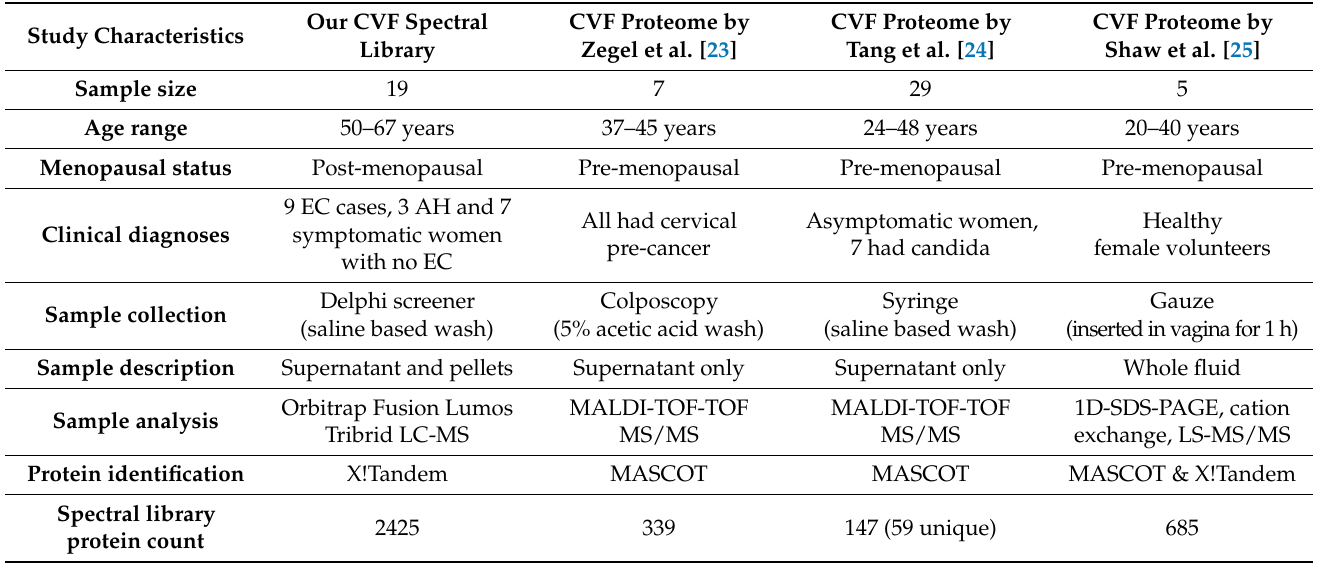
Table 4. Comparative overview of the various studies on the cervico-vaginal (CVF) proteome conducted in non-pregnant women. Study Characteristics